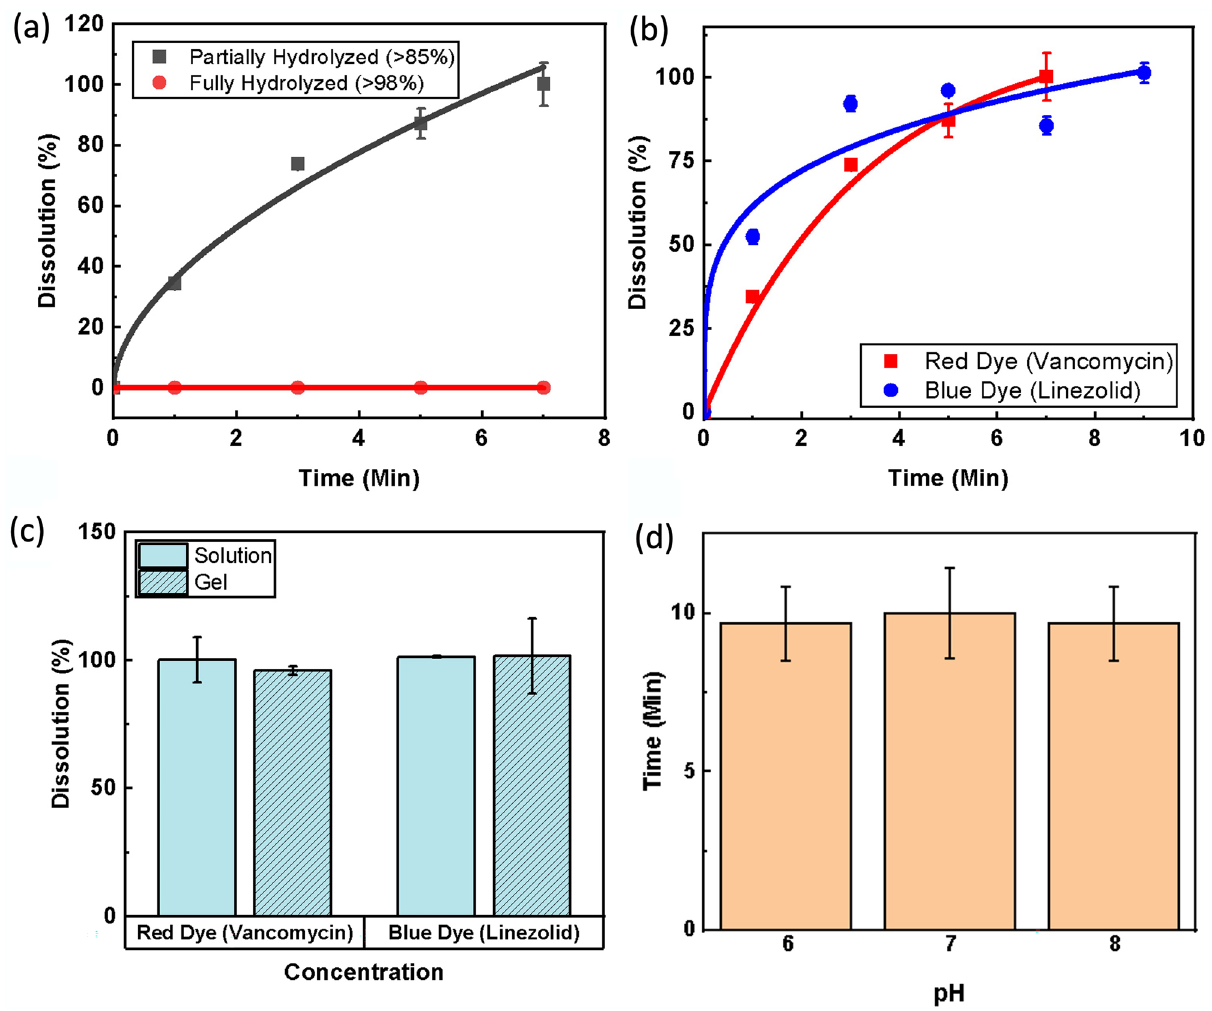
Figure 5. Dissolution characterization of drug eluting NFs. ( a ) Dissolution rate of NF fabricated with partially hydrolyzed and fully hydrolyzed PVA. ( b ) Dissolution over time of partially hydrolyzed NFs infused with drug mimicking dies (Red for vancomycin and Blue for linezolid). ( c ) Proportion of material dissolved by critical time of 10 min (< 3% total treatment duration) for NFs in liquid and gel media. ( d ) Comparison of time needed to achieve critical dissolution of blue dye (linezolid) NFs in buffer solution with different pH levels. Error bars denote standard